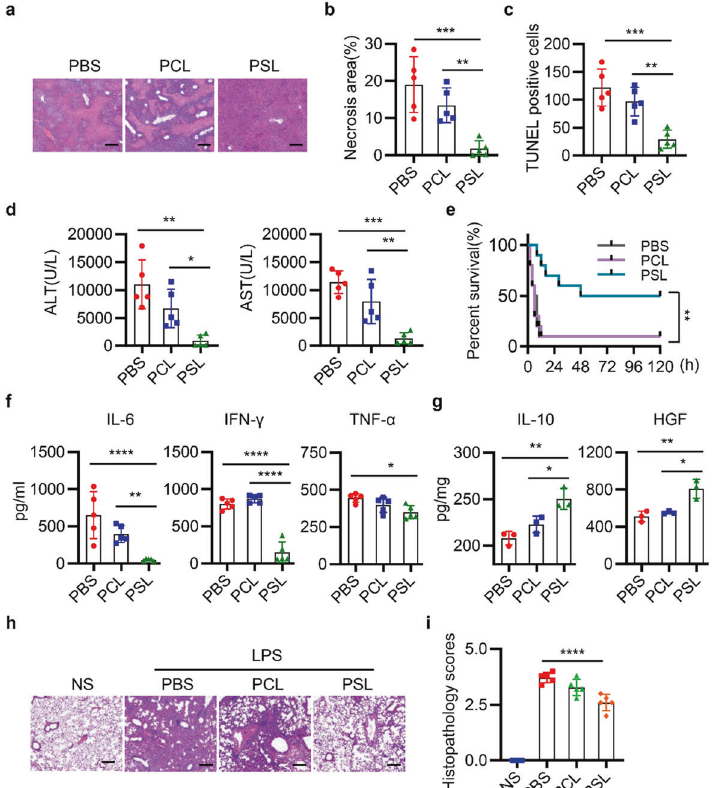
Fig. 5 PSLs ameliorate ConA-induced ALI and LPS-induced lung injury. a Mice were intravenously injected with 12 mg/kg ConA, followed by treatment with PBS, PCLs, or PSLs. Representative images of liver histopathology with H&E staining in each group. Scale bar represents 200 μ m. b – d Quantitative analysis of necrosis area ( b ), TUNEL-positive cells ( c ), and serum ALT and AST levels ( d ) in mice with PBS, PCLs, or PSLs treatment. n = 5. e Survival of 25 mg/kg ConA-injected mice treated with PBS, PCLs, and PSLs. n = 10. f , g The levels of IL-6, IFN- γ , and TNF- α in serum ( f ) and IL-10, HGF in hepatic tissues ( g ) were determined by ELISA. n = 3~5 in each group. h Representative images of lung histopathology 72 h after LPS administration. Scale bar represents 200 μ m. i Histopathology score of lung sections in each group. n = 5 in each group. Data are represented as mean ± SEM. * p < 0.05, ** p < 0.01, *** p <